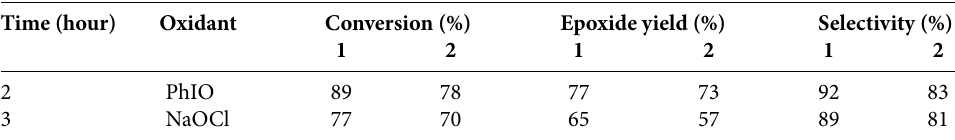
Table 4. Catalytic epoxidation